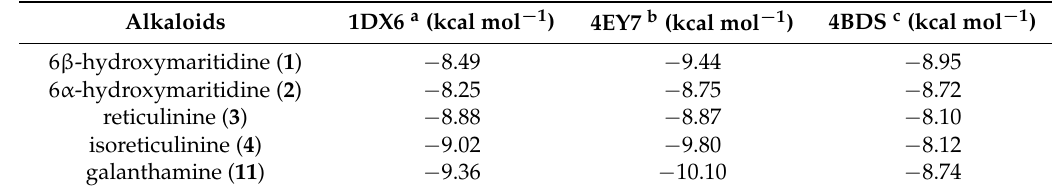
Table 5. Estimated energies of reaction and inhibition constants for the new compounds in the active sites of AChE and